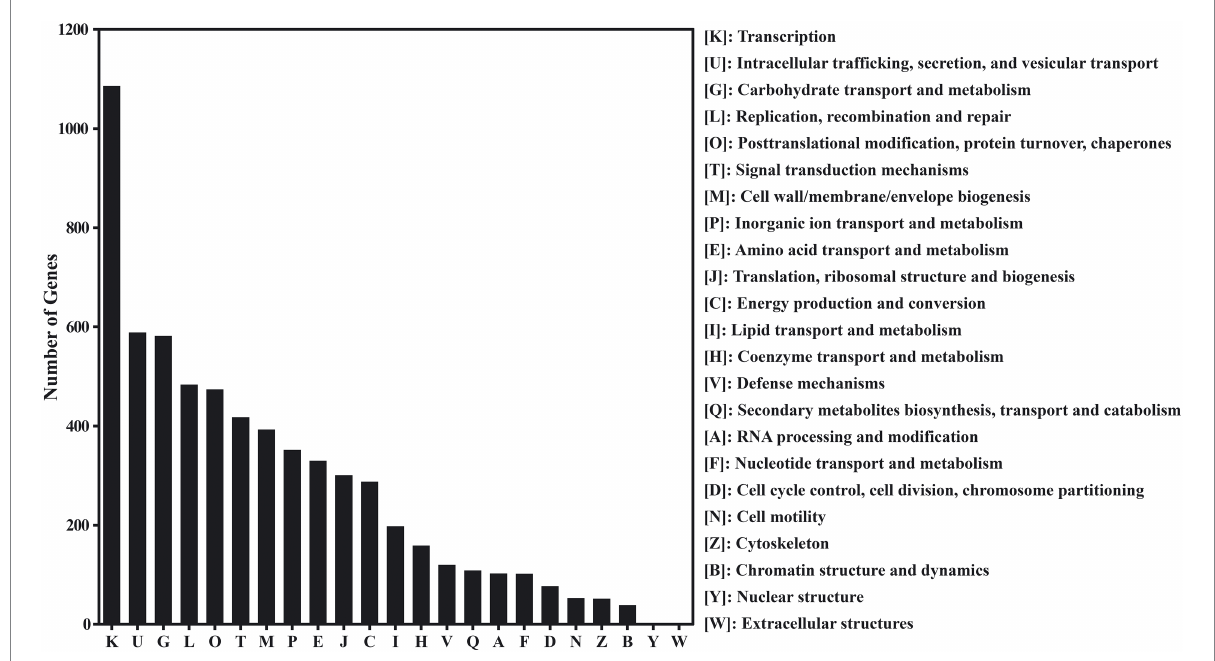
FIGURE 2 The evolutionary genealogy of genes: Non-supervised Orthologous Groups (eggNOG) gene’s functional classification in red vinasse acid.